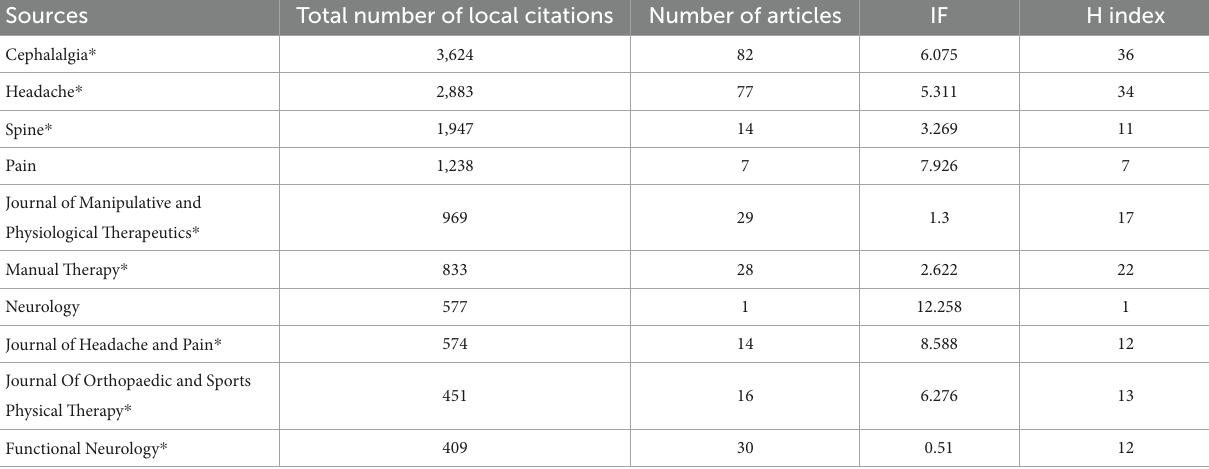
TABLE 3 Ranking of the top 10 journals with the most local citations for CEH-related